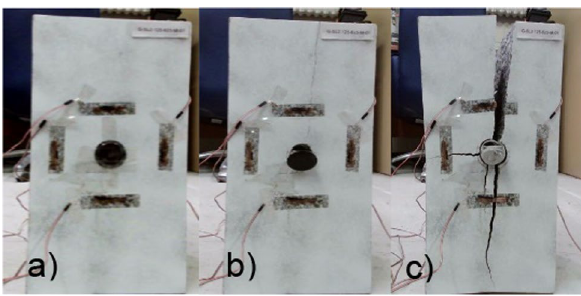
Fig. 9 G-SL2-125-625-M-01 a At time t